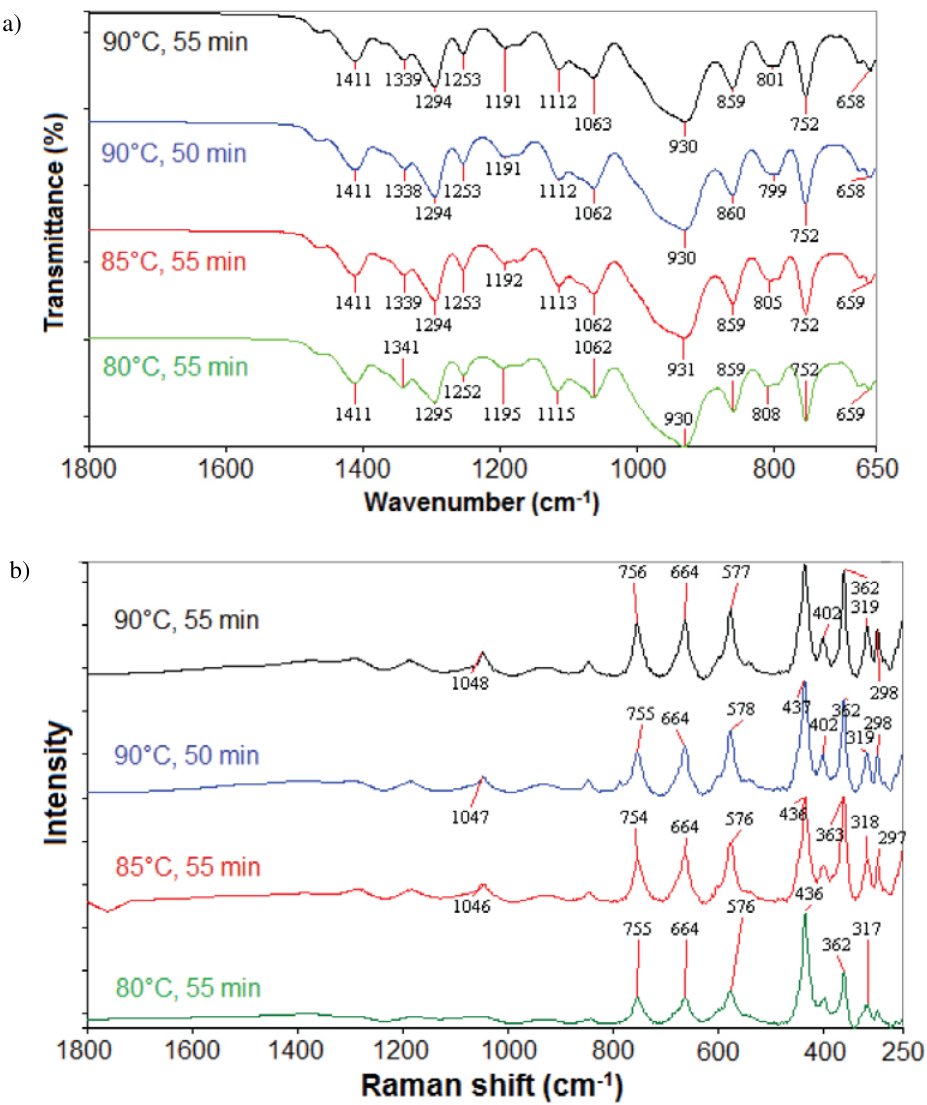
Fig. 3. a. FT-IR spectra of the synthesized pure zinc borates, b. Raman spectra of the synthesized pure zinc